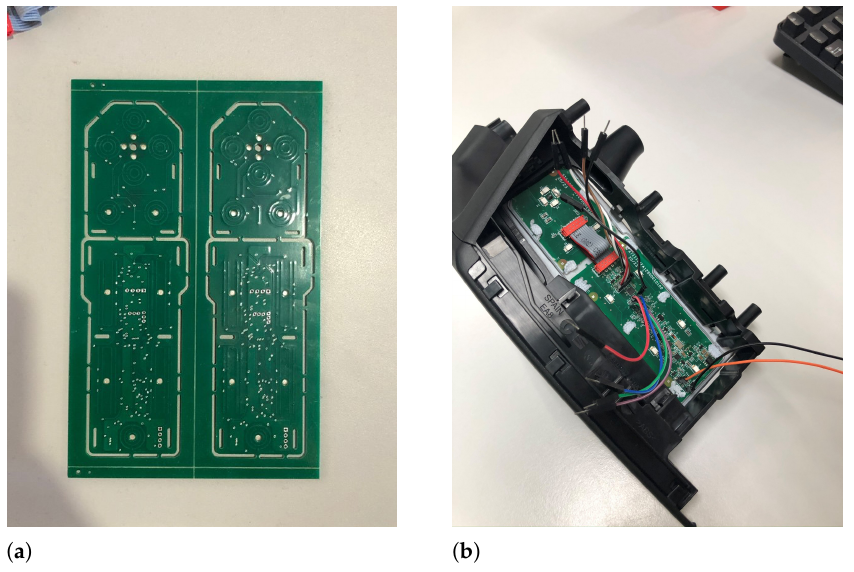
Figure 18. ( a ) PCB with 19 capacitive sensors supported. ( b ) The finished prototype ready to be incorporated in the automobile’s